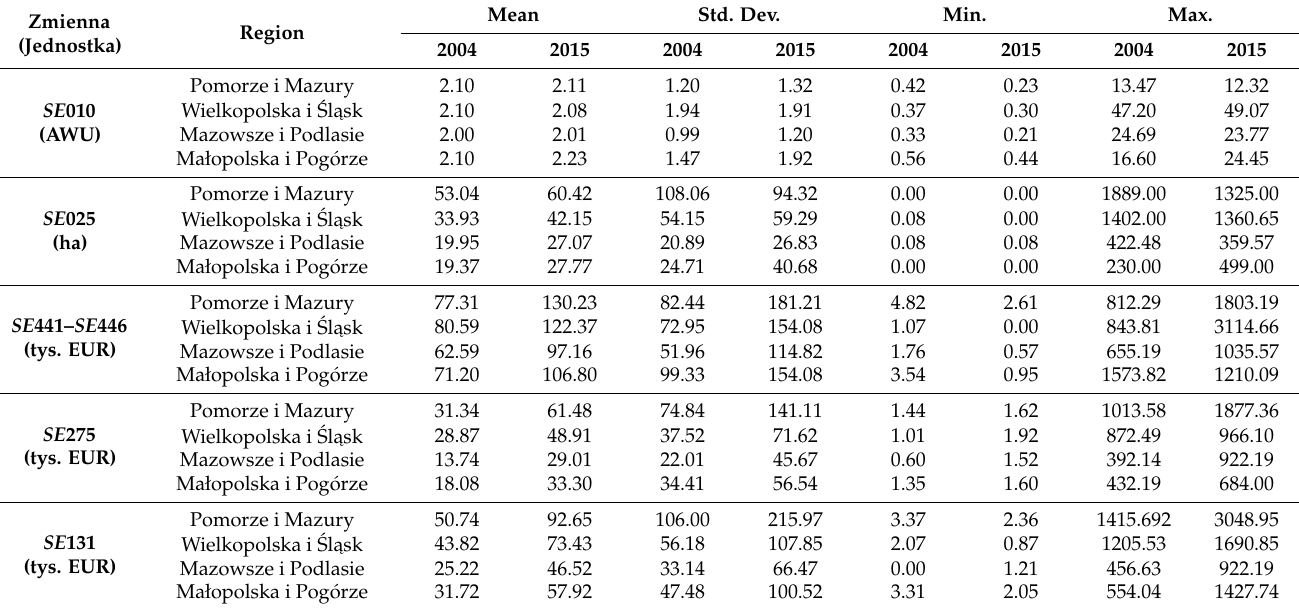
Table 2. Descriptive statistics of the variables included in the